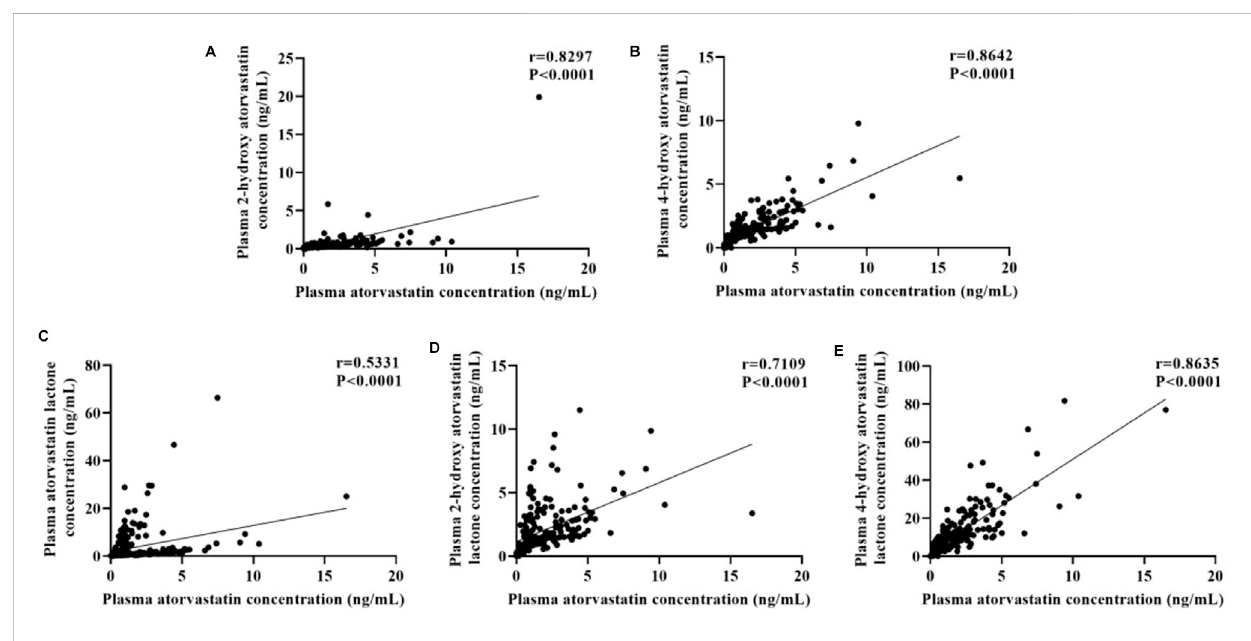
FIGURE 2 Correlations between plasma concentration of atorvastatin and its metabolites: (A) 2-hydroxy atorvastatin; (B) 4-hydroxy atorvastatin; (C) atorvastatin lactone; (D) 2-hydroxy atorvastatin lactone; (E) 4-hydroxy atorvastatin lactone.